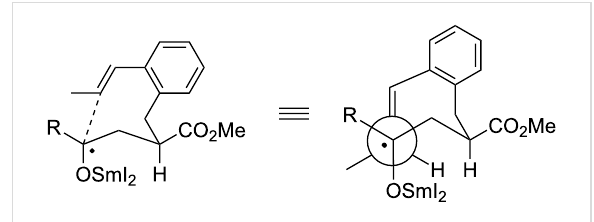
Figure 4: Proposed transition structure for the cyclization of ( E )-1- propenyl-substituted substrates (HMPA ligands and proton donors ROH at the samarium are omitted for